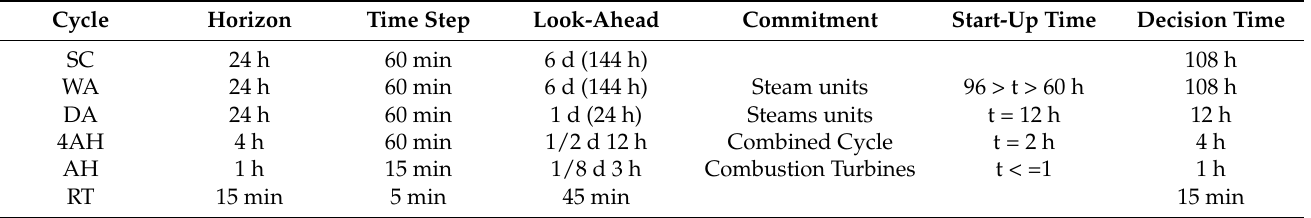
Table 2. Key details that describe the multicycle rolling horizon modeling implemented in this